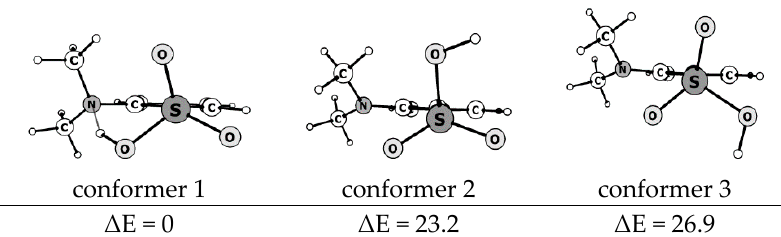
Figure 8. The structure of the 2-N(CH 3 ) 2 -BSAconformers and their relative energies ( Δ E, kJ mol − 1 ).